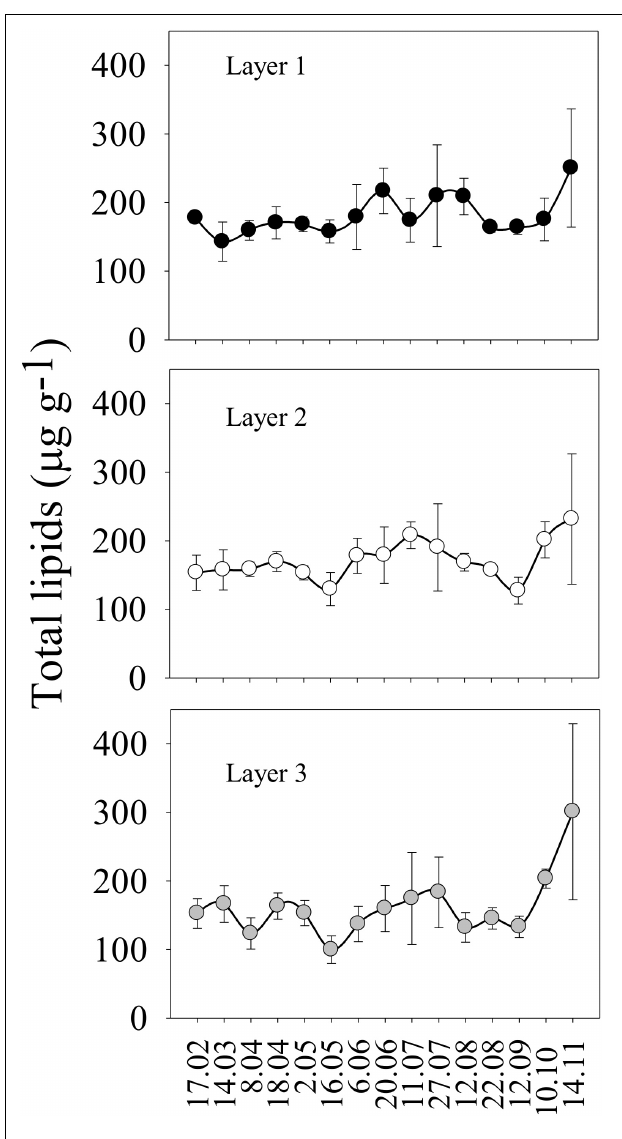
FIGURE 3 | Temporal dynamic (from February to November 2016) of total lipids concentration ( µ g/g of sediment) in the seafloor sediment per layer (layer 1: 0–0.4 cm, layer 2: 0.5–1.5 cm, and layer 3: 5–6 cm). Mean ± SD are